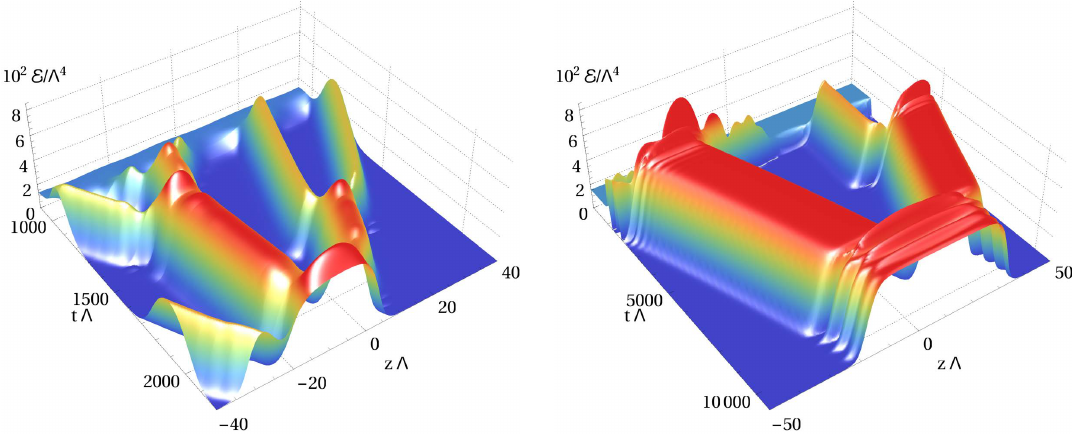
Figure 6 . Zoom into the respective spacetime evolution of figure 5 (left) out-of-equilibrium peak ↔ peak merger (right) Merger of settled peak ↔